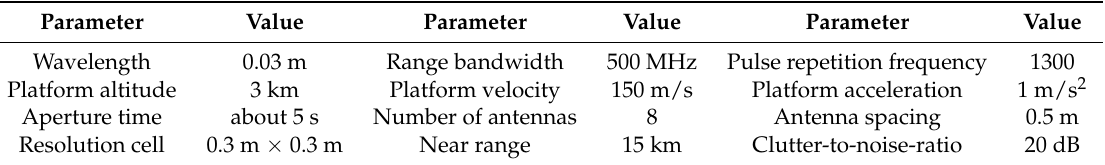
Table 1. Simulation